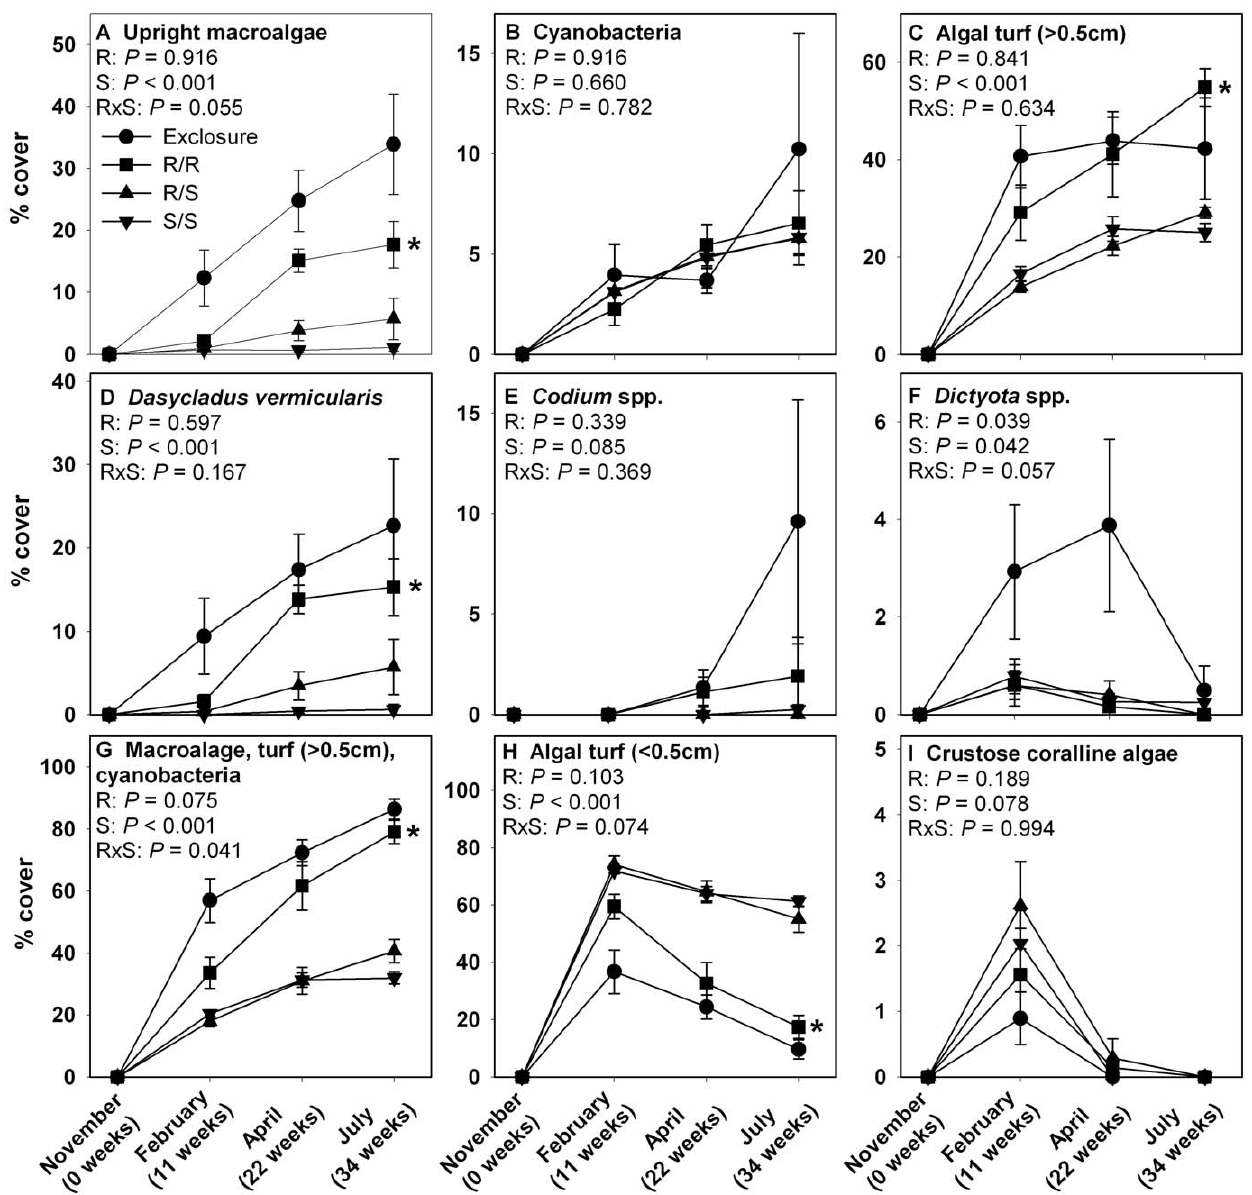
Figure 1. Percent cover (mean 6 SE) of common algal types over time during Year 1. R = redband parrotfish and S = ocean surgeonfish. Statistics are from repeated measures, two-factor ANOVA. * indicates a single-herbivore treatment that differs from the mixed-herbivore treatment as determined via resampling statistics. n =8 for Exclosure, n =6 for R/R, n =6 for R/S, and n =8 for S/S. Note different Y-axes.